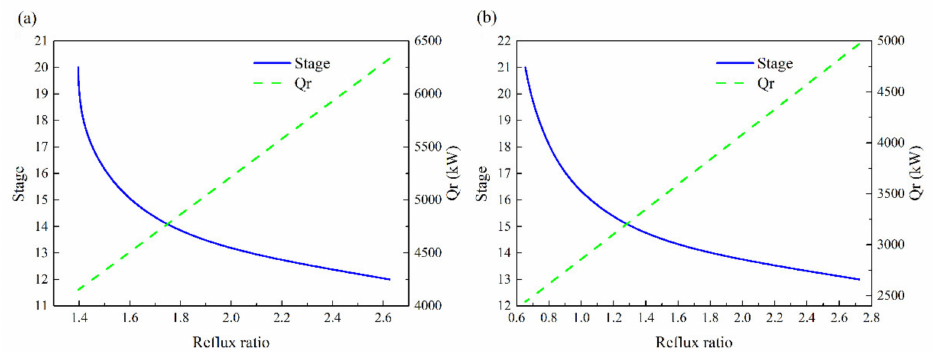
Figure 7. Variation of stage number and heat duty as a function of the reflux ratio for the C1 ( a ) and C2 ( b ).